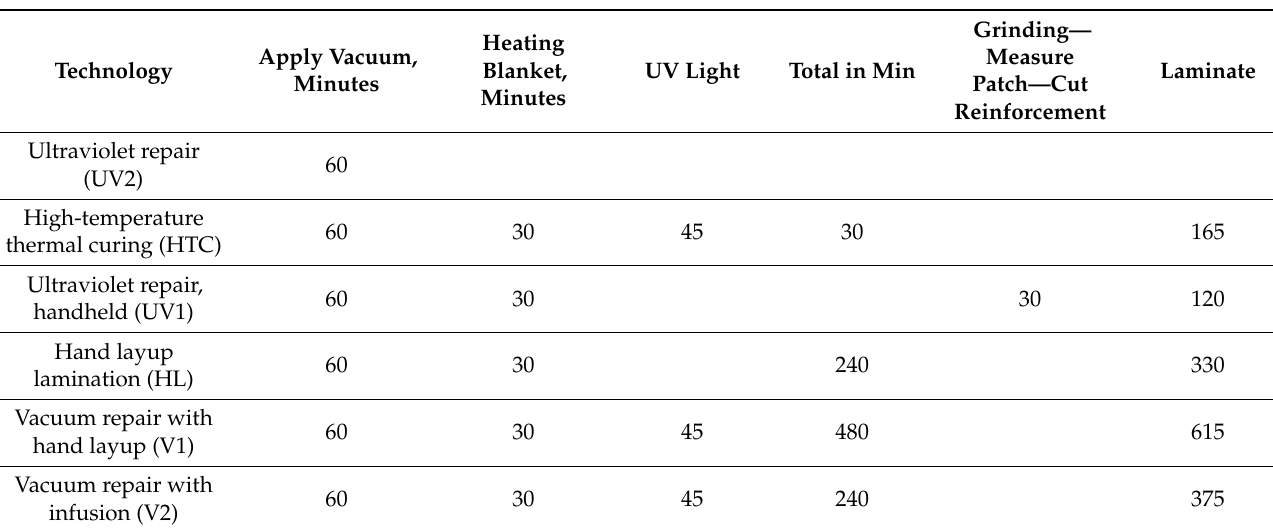
Table 2. Overview: Temperatures and duration of curing.